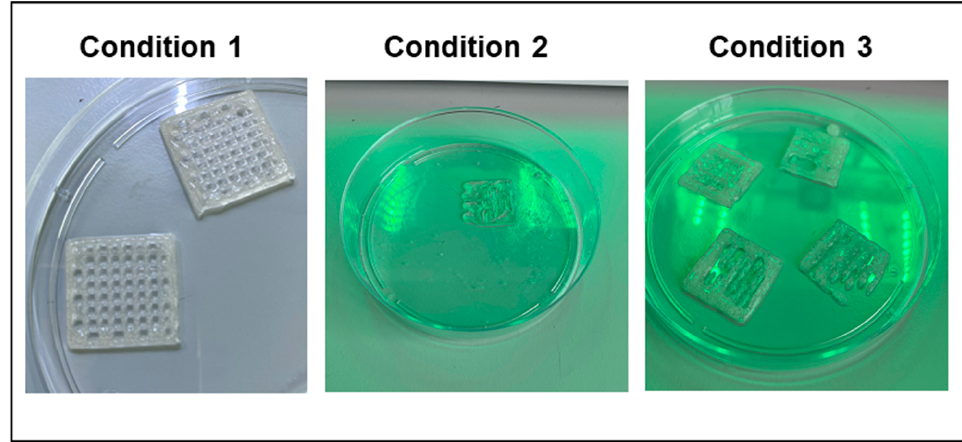
Figure 1. GEL–ALG scaffolds printed under the three conditions